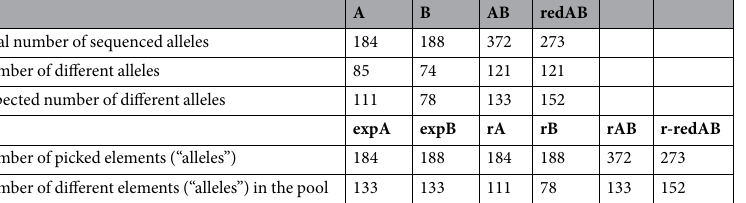
Table 1. Number of csd alleles identified within the given honey bee groups and number of elements in randomly generated reference datasets. Upper part: the total number of identified sequences, different alleles and expected number of different alleles. The expected number of different alleles was calculated under the assumption of their uniform distribution within a given group. Lower part: number of elements constituting the reference random datasets and the number of different elements in the pool from which they were drawn.